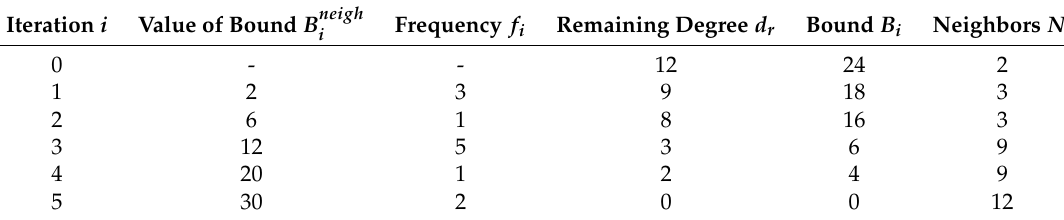
Table 1. Frequency distribution of bound B for the neighbors of node 0 in Figure